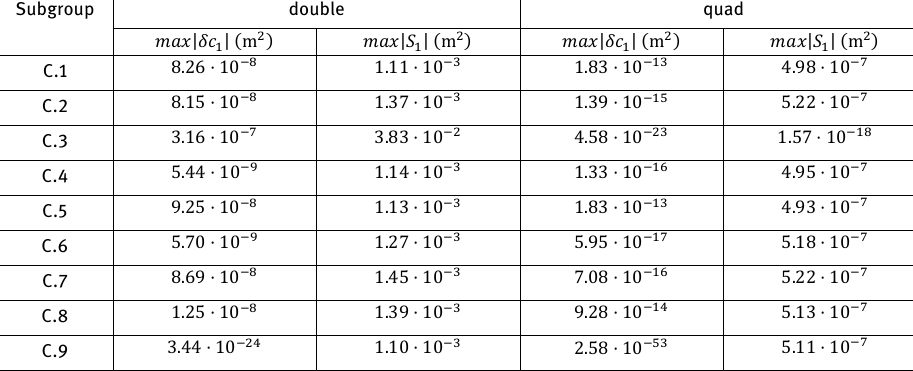
Table 12: Results in the Group C